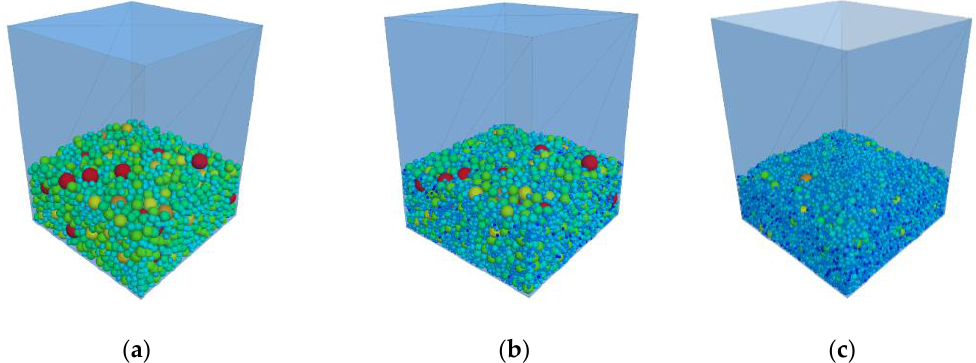
Figure 8. Schematic diagram of 9.5–31.5 mm aggregate and 4.75–9.5 mm aggregate in different mass ratios. ( a ) (M 1 + M 2 ):M 3 = 100:0, ( b ) (M 1 + M 2 ):M 3 = 70:30, ( c ) (M 1 + M 2 ):M 3 = 80:20.